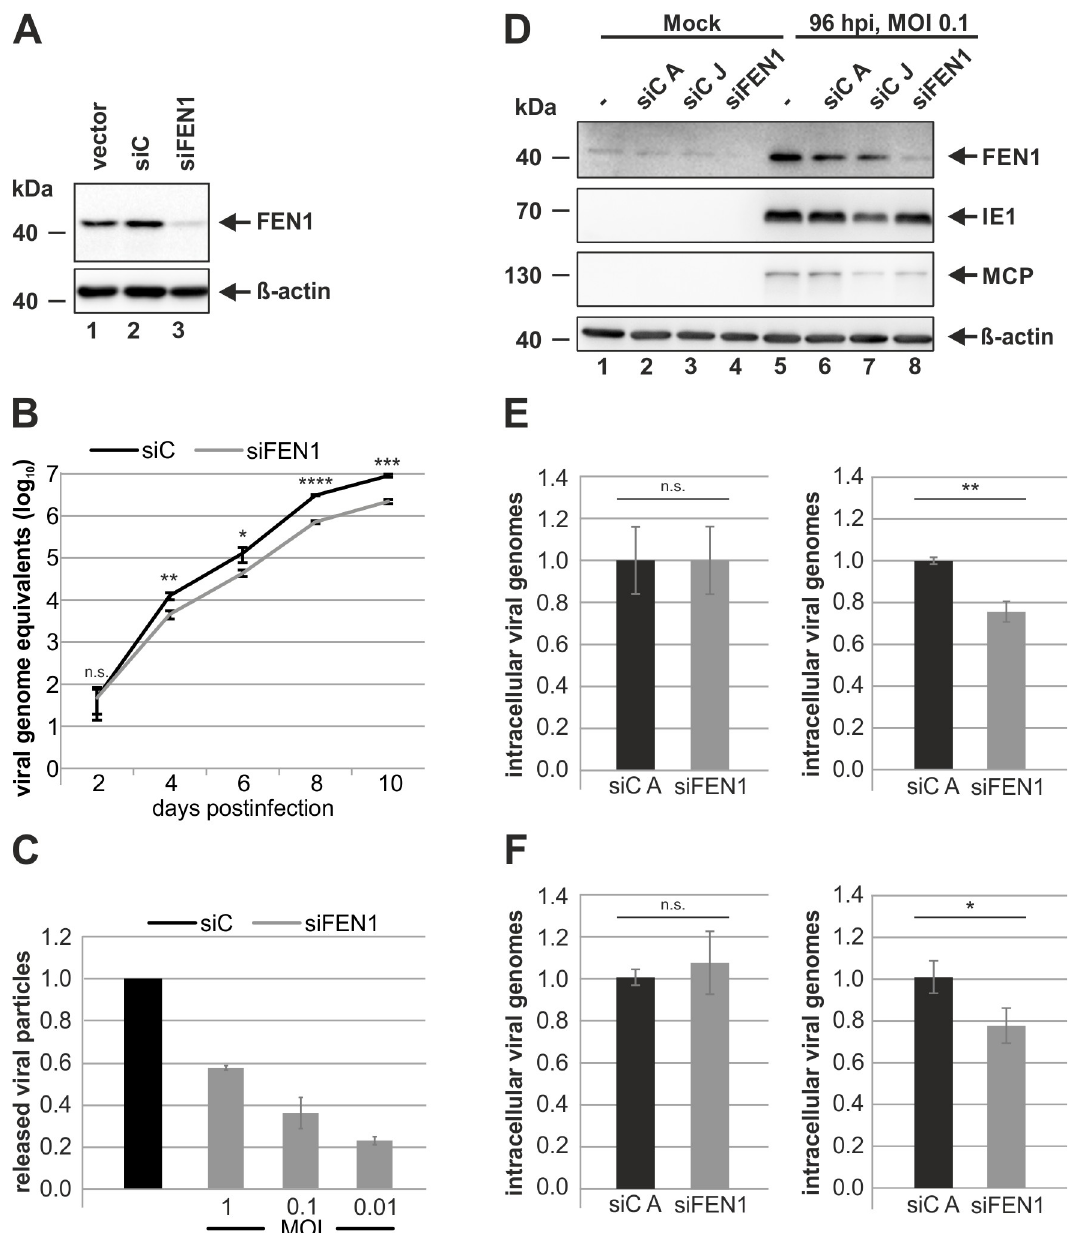
Fig 5. Promotion of viral DNA replication by FEN1. (A) Detection of FEN1 protein levels in vector-, siC-, and siFEN1-transduced HFFs by Western blotting. β -actin levels served as loading control. (B and C) siC- and siFEN1-transduced HFFs were infected at an MOI of 0.01 (B) or at indicated MOIs (C) and multistep growth curve analysis (B) or virus release assay (C) was performed. Cell supernatants were harvested at the indicated times after infection and analyzed for viral genome equivalents by HCMV IE1-specific quantitative real-time PCR. For C, siC-transduced HFFs were set to 1. Values are derived from biological triplicates and represent mean values ± SD. (D) HFF cells were either transfected with two control siRNAs (siC A and siC J) or siRNA directed against FEN1 or left untreated. 24 h later, cells were either directly harvested (Mock) or infected with AD169 at an MOI of 0.1 and harvested 96 hpi. Cells were analyzed by Western blotting for FEN1, IE1, MCP, and β -actin. (E and F) siC A- and siFEN1-transfected HFFs were infected with AD169 (E) or TB40/E (F) at an MOI of 0.1, and total DNA was extracted at 8 hpi (left) and 96 hpi (right) using the DNeasy blood and tissue kit (Qiagen). Viral genomes were quantified by TaqMan real-time PCR specific for IE1, and genome copy numbers were calculated. siC A-transfected HFFs were set to 1. Values are derived from biological triplicates and represent mean values ± SD. For panels B, E, and F, the p-values were calculated using two-tailed Student’s t-tests. n.s., not significant; ���� , p � 0.0001; ��� , p � 0.001; �� , p � 0.01; � , p � 0.05.